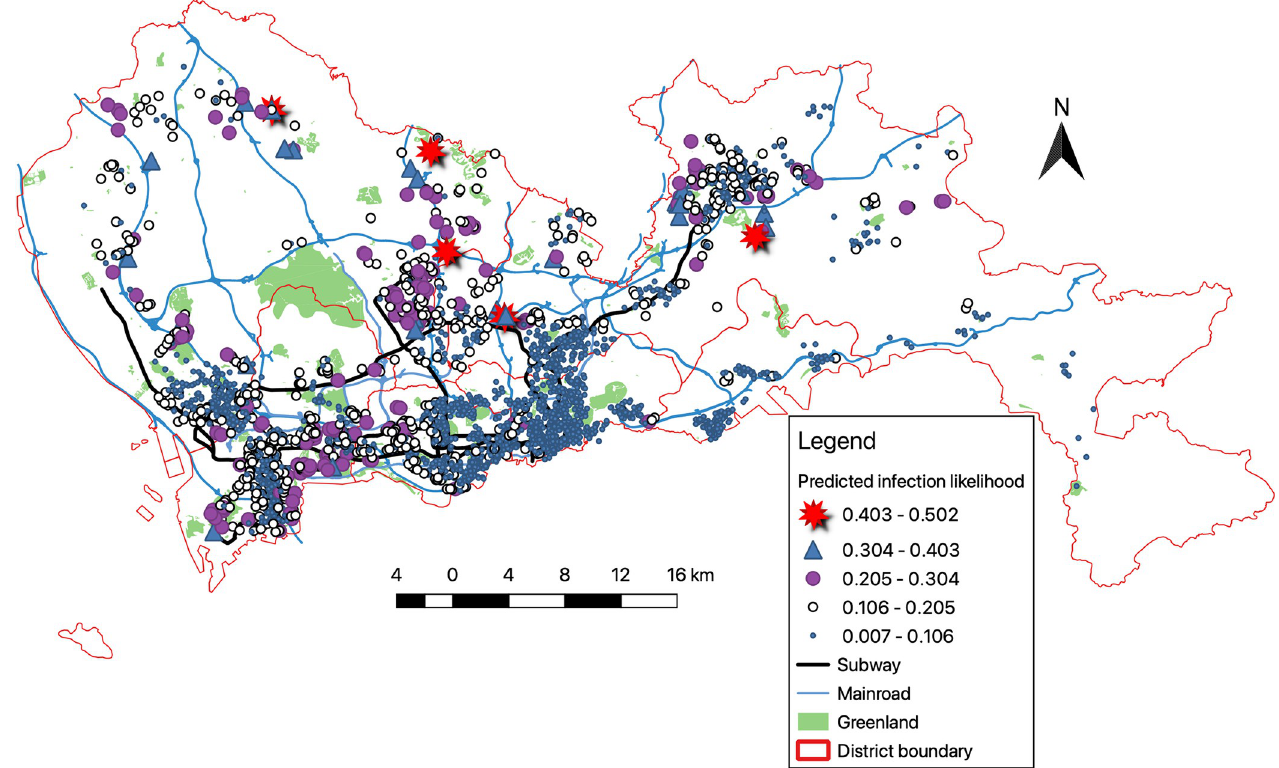
Fig 4. The predicted likelihood of COVID -19 infection using the average 2020 list